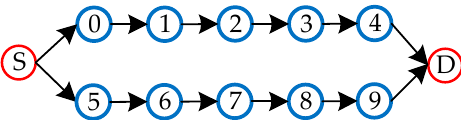
Figure 14. Node independent multipath routing.